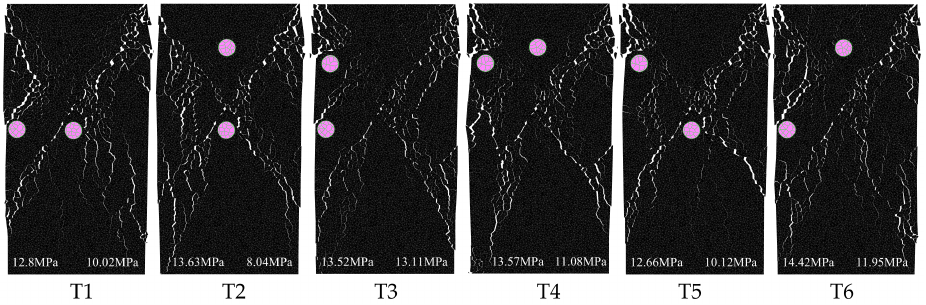
Figure 18. Crack pattern of two mineral circles located at different positions after sample is broken